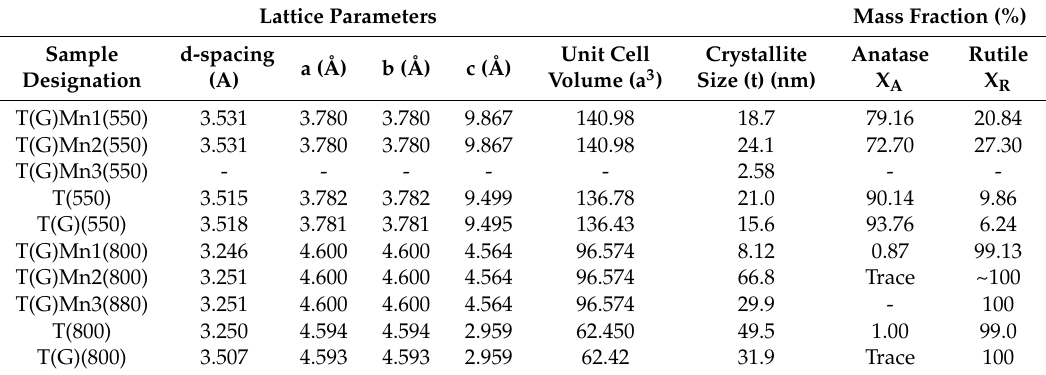
Table 2. Summary of textural parameters (lattice parameters, mass fractions) for various sample designations obtained from XRD